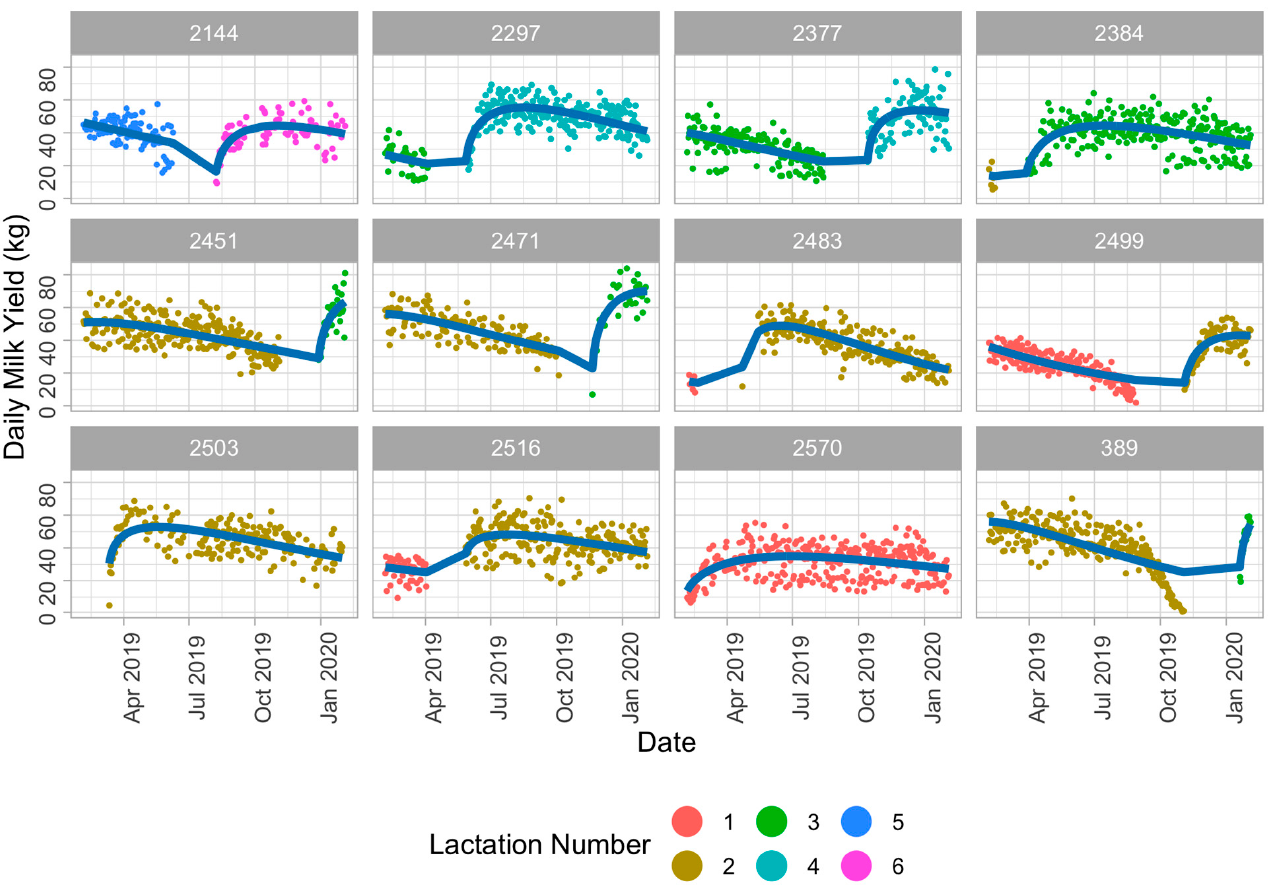
Figure 1. Examples of the expected and actual milk production data. The expected values are determined from the nonlinear, Wood’s curve mixed model with random effects of lactation number nested within cow. Here we illustrate that the trends in actual milk production correspond to the expected values, which account for lactation number and stage of lactation (blue